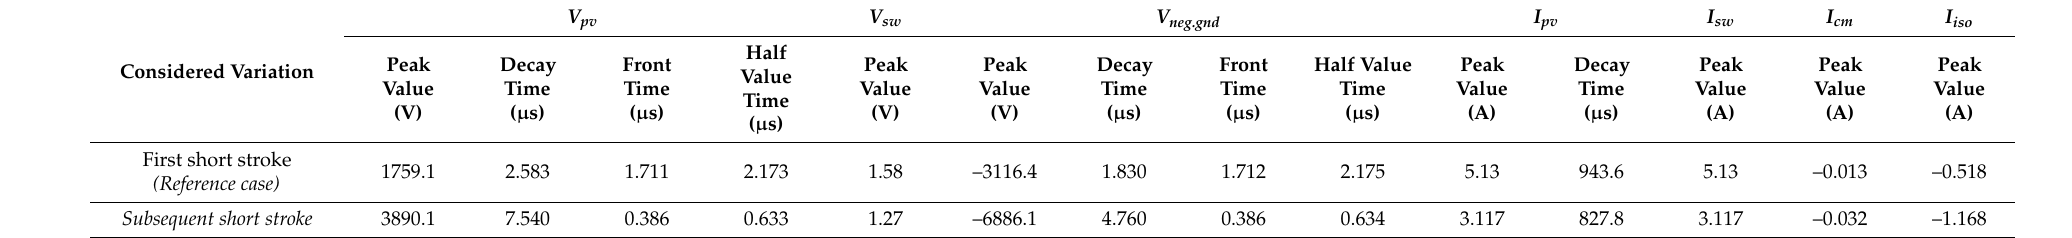
Table 7. Sensitivity analysis for induced voltages and currents for different lightning current waveforms.